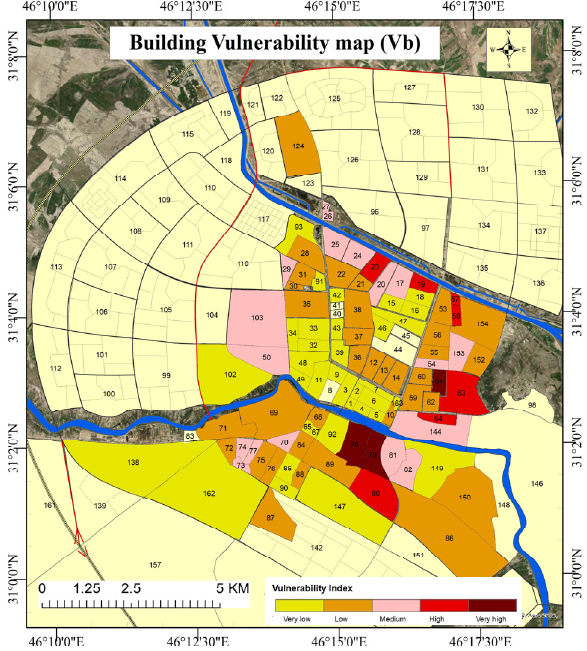
Figure 16. Building vulnerability map (Vb).